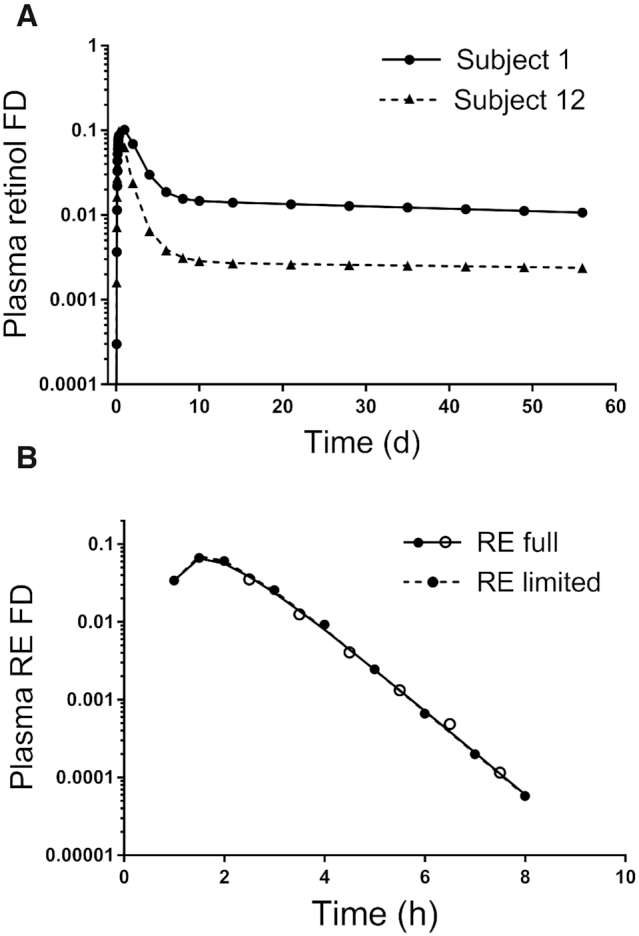
Simulated data (symbols) and model predictions (lines) for plasma retinol over 56 d for subjects 1 and 12 (A) and for retinyl esters over 10 h for subject 6 (B). In panel A, plasma retinol data (without error) as fraction of the oral dose are shown for subjects who had assigned values for vitamin A absorption efficiency of 55 (subject 1) and 90% (subject 12). Absorption was fixed at 75% to obtain the model predictions. In panel B, data are plasma REs with 5% random error for the subject whose assigned value for vitamin A absorption efficiency was the same as the mean for the group (72%) and model-calculated fits to the full (16 samples) and limited sampling data sets (10 samples). See Supplemental Table 1 for subject details. FD, fraction of administered dose; RE, retinyl ester.